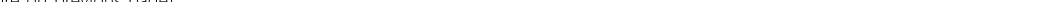
23.13, and 114.33 ± 10.75 μ moI/L in sham, WT and Xbp1 + / − groups, respectively ( P < 0.01; Fig. 2C), while those of NGAL were 19.42 ± 3.66, 613.01 ± 46.51, and 68.56 ± 7.44 ng/mL in the three groups, respectively ( P < 0.01; Fig. 2C), suggesting Xbp± kidneys were more resis- tant to IR-induced dysfunction than those of WT mice.